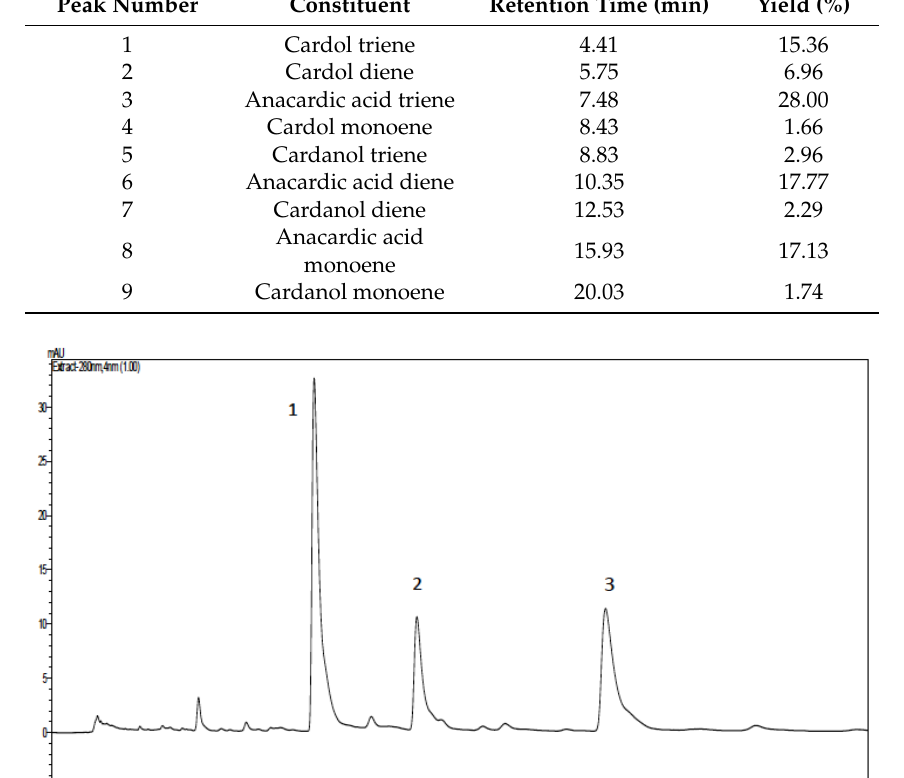
Table 1. High performance liquid chromatography (HPLC) analysis of natural cashew nut shell liquid.